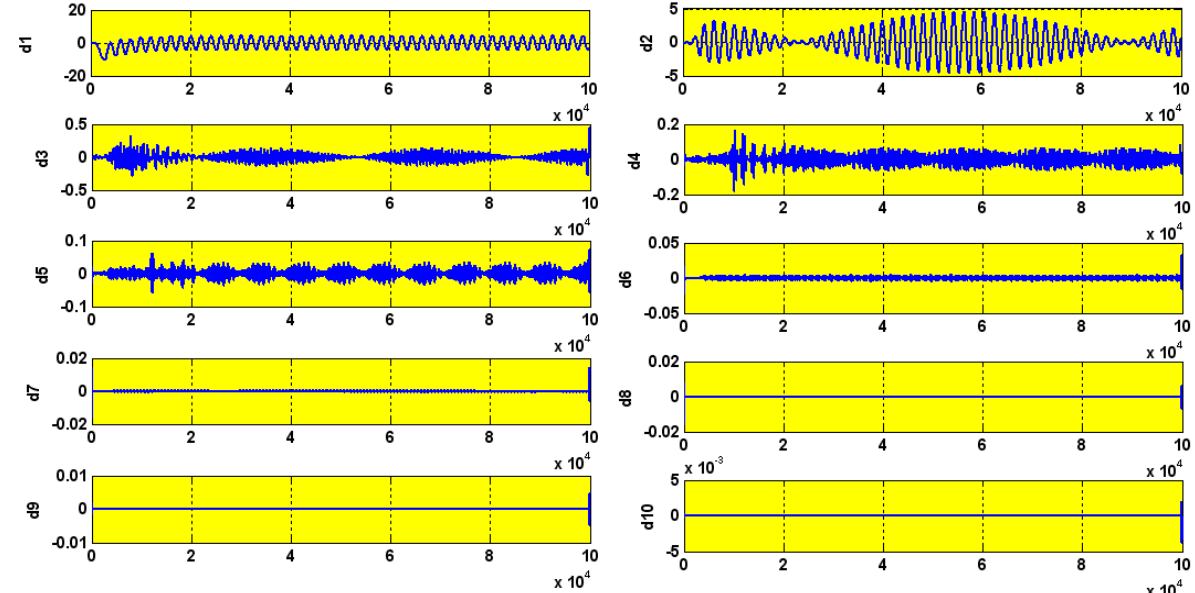
Figure 18. Wavelet decomposition.